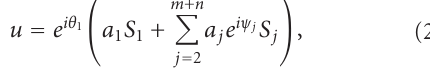
carries as much information as possible and thus approxi-